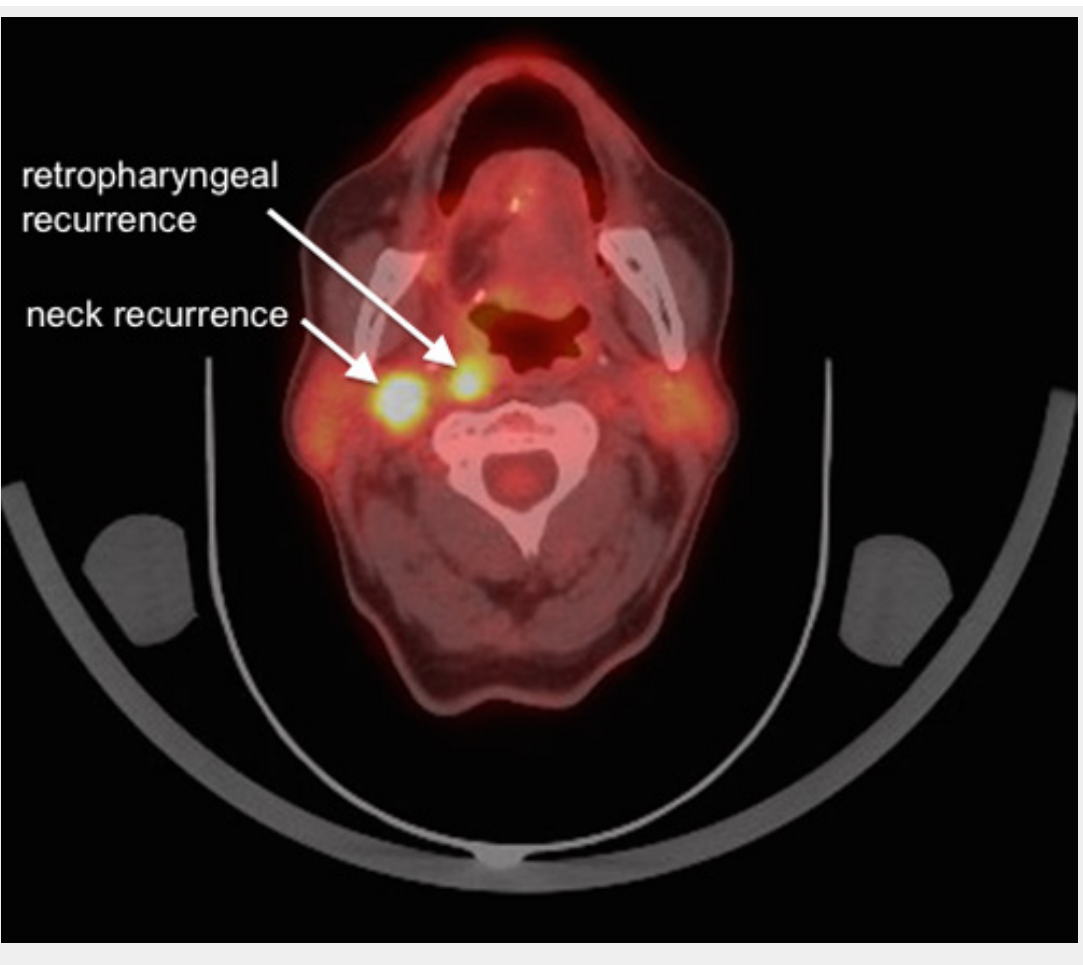
Figure 3 The same follow-up 18F-FDG-PET/CT scan showing the fused 18F-FDG-PET part with the CT part. There is no evidence for local recurrence at the reconstruction site however there are two highly suspicious lymph nodes in level IIb ipsilateral and